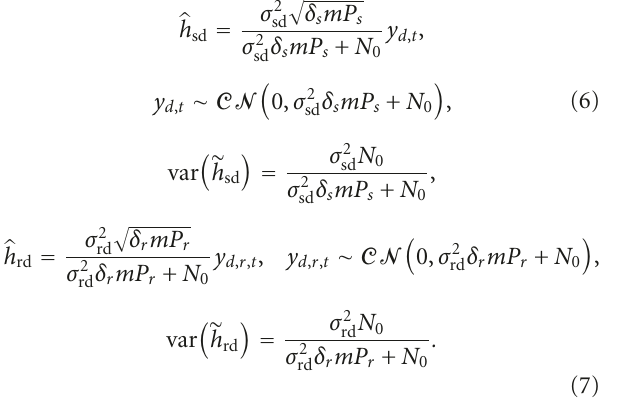
), and h rd ∼ CN (0, σ 2 sd